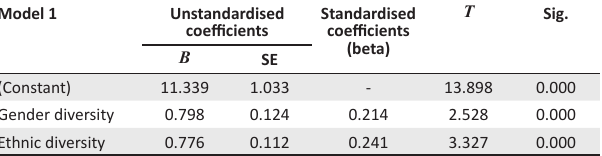
TABLE 10: Gender diversity and ethnic diversity as predictors of employee performance. Model 1